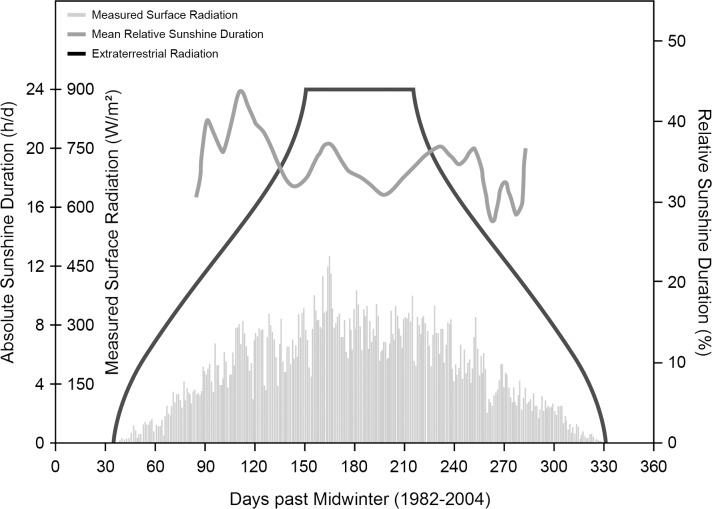
Duration of sunshine at the Neumayer Stations in AntarcticaPlots of extraterrestrial radiation (black), relative sunshine duration (dark grey) and measured surface radiation (light grey) at the location of the Neumayer Stations The x-axis displays the time in days with “0” representing midwinter (June 21st).